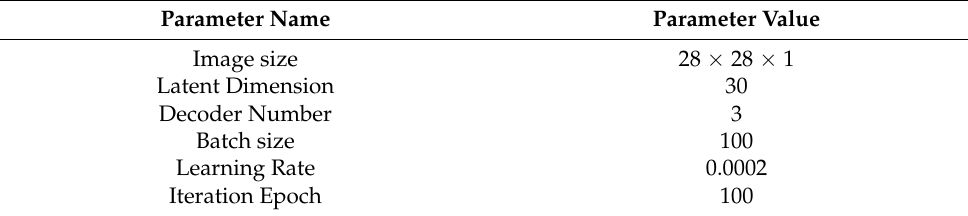
Table 4. The deep learning